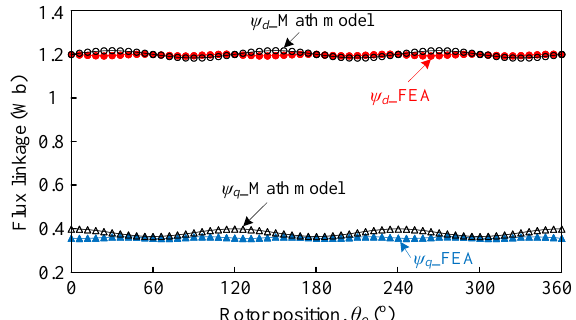
Figure 8. Waveforms of the flux linkage in d-q axes frame under i d = 0 control.